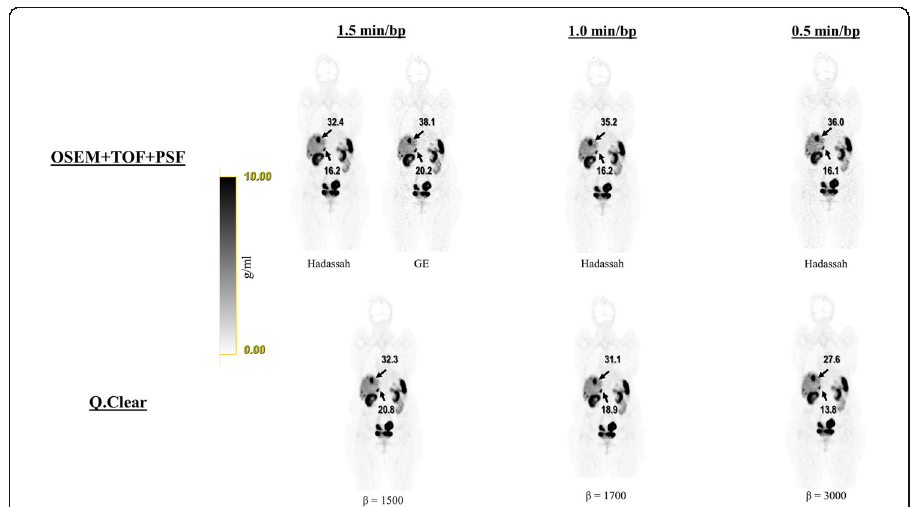
Fig. 7 Representative coronal 68 Ga-DOTA images of patient no. 1 reconstructed with Hadassah (1.5, 1.0 and 0.5 min/bp) and manufacturer recommendation GE OSEM (1.5 min/bp) and, Q.Clear, for 1.5, 1.0 and 0.5 min/ bp and β = 1500, 1700 and 3000, respectively. The image quality of Q.Clear with 1.0 and 0.5 min/bp is better compared to Hadassah OSEM with the same acquisition time and is similar when using 1.5 min/bp. The image quality seems better with Q.Clear than for GE OSEM for all acquisition times. SUV max uptake values (g/ml) obtained with the different reconstruction methods for two lesions are indicated by arrows. The gray scales next to the images represents the corresponding SUV scale in g/ml